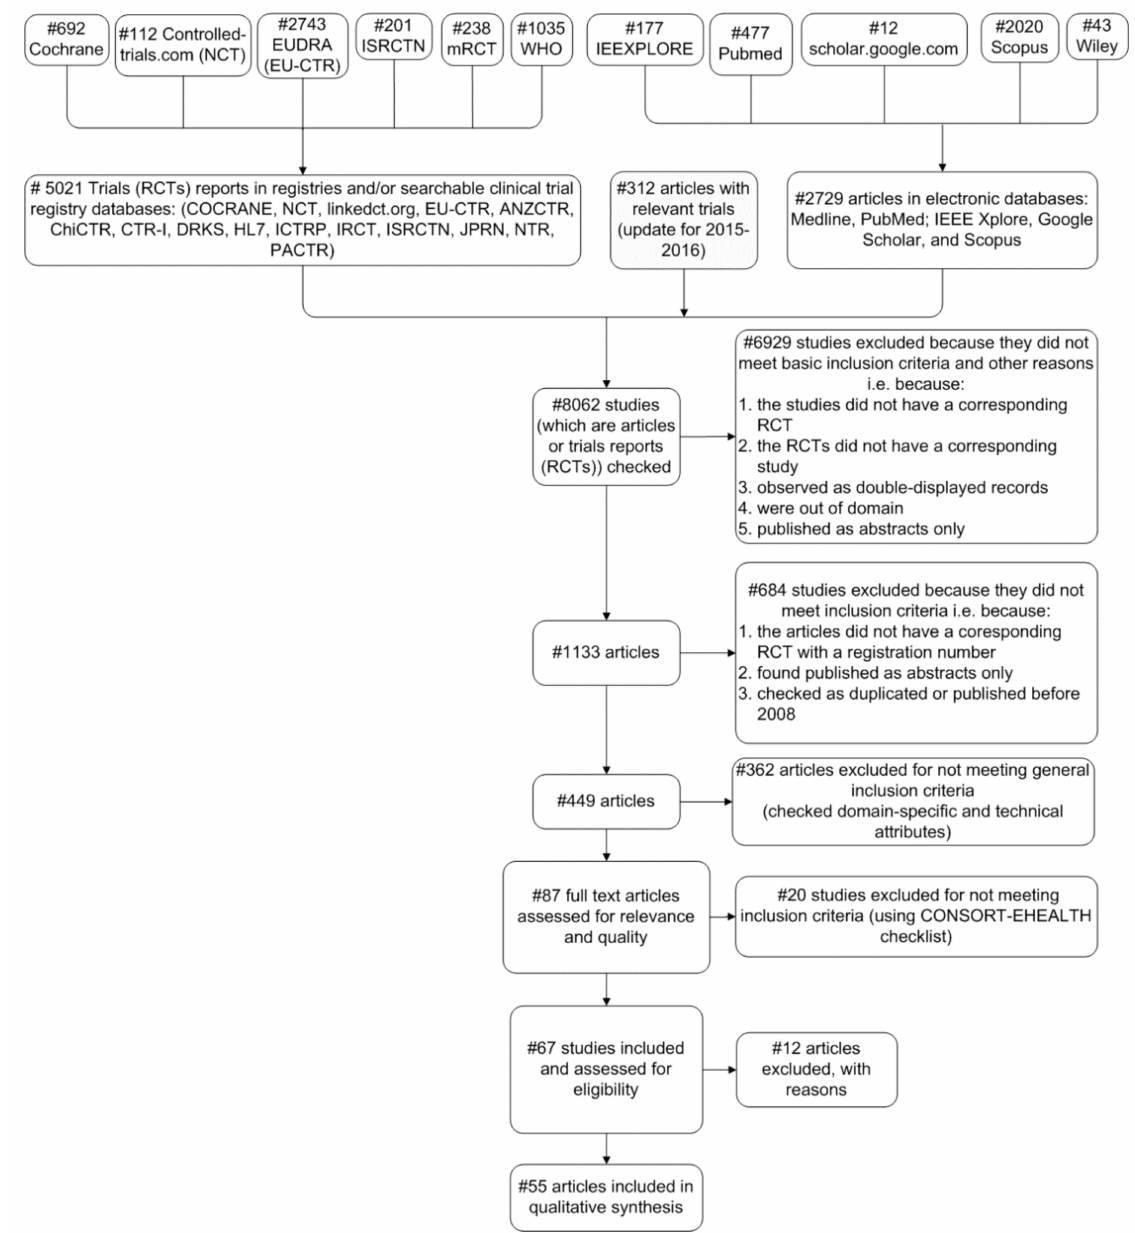
Figure 1. Flow chart of our study selection process ( PRISMA 2009 flow